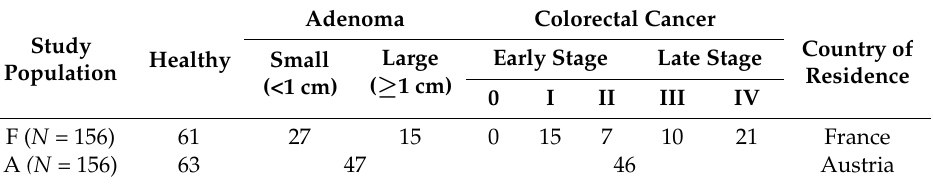
Table 3. Information about the two sample